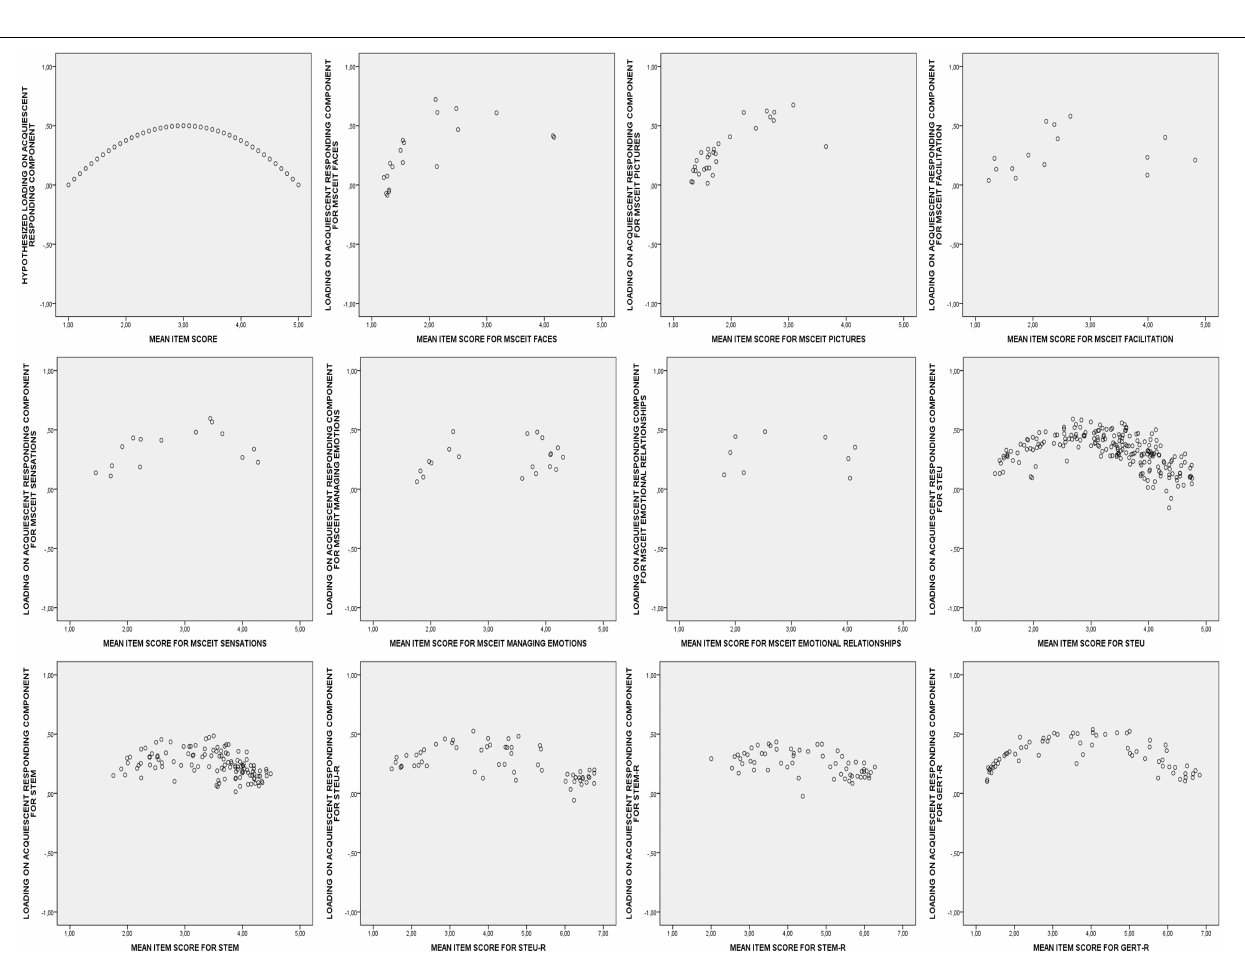
FIGURE 2 | Hypothetical and observed plots of the mean item scores and the item loadings on the unipolar acquiescent responding component for the 11 EI